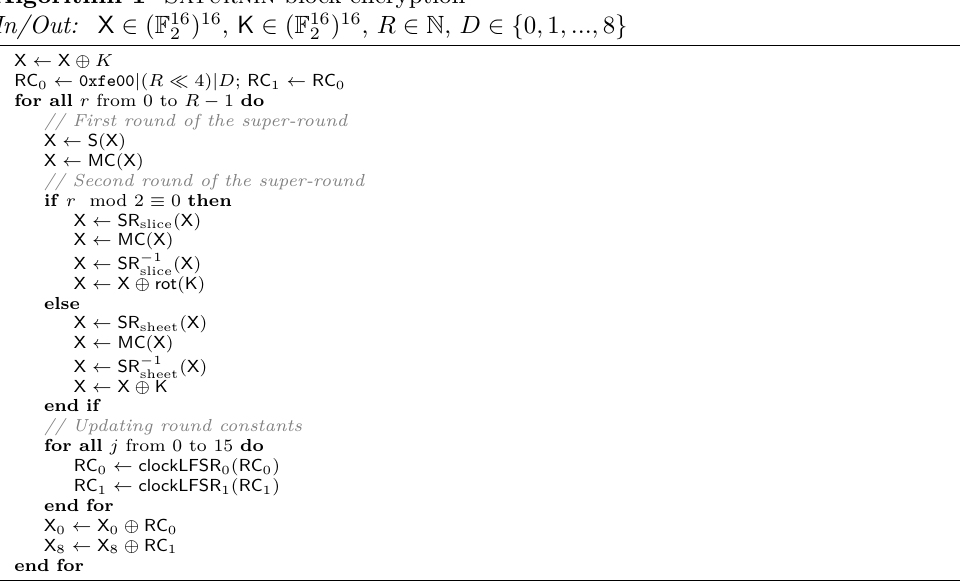
Algorithm 1 Saturnin block